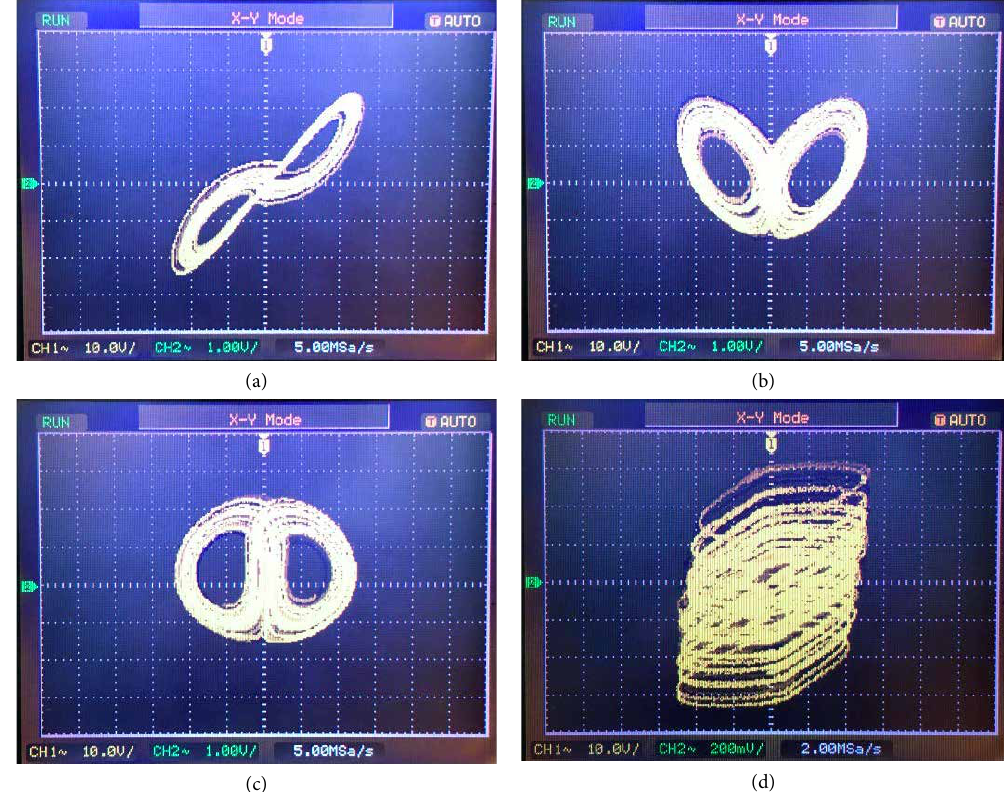
Figure 13: Chaotic attractors observed from an analog oscilloscope. (a) x - y plane; (b) x - z plane; (c) y - z plane; (d) x - w